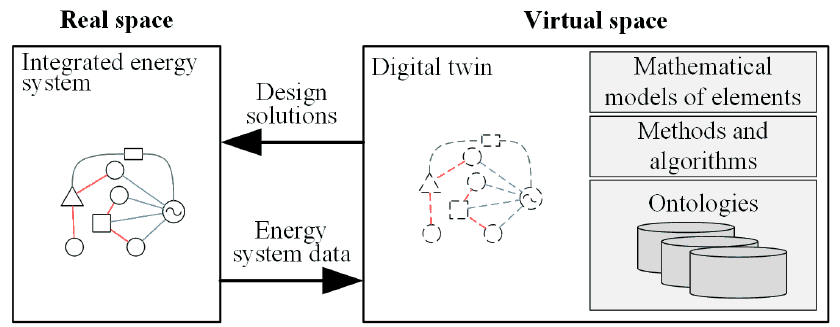
Figure 1. Designing an integrated energy system based on its digital twin.